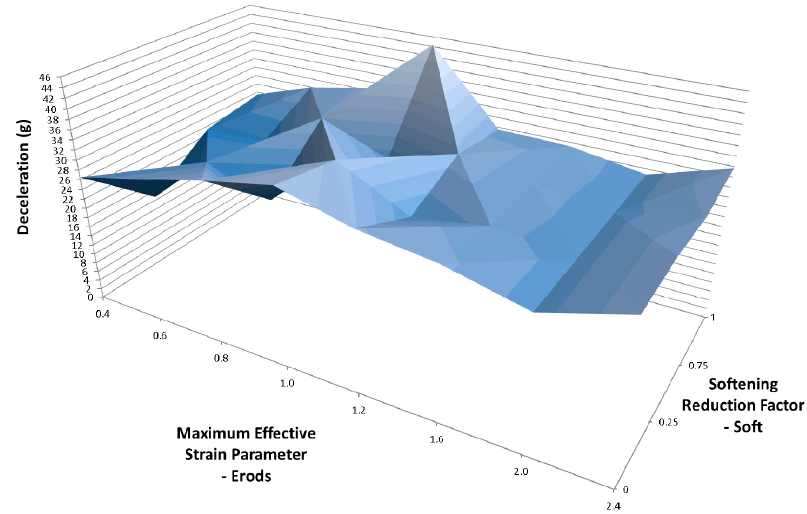
Figure 15. Effect of Erods parameter and Soft factor with All Slim = 1.0, TSize = 1 × 10 − 8 and FS = − 1.0.